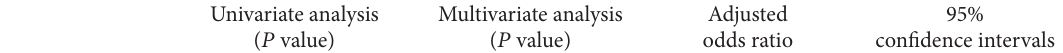
Table 4: Logistic regression model of P300a amplitude (in Fz area and in ON period).